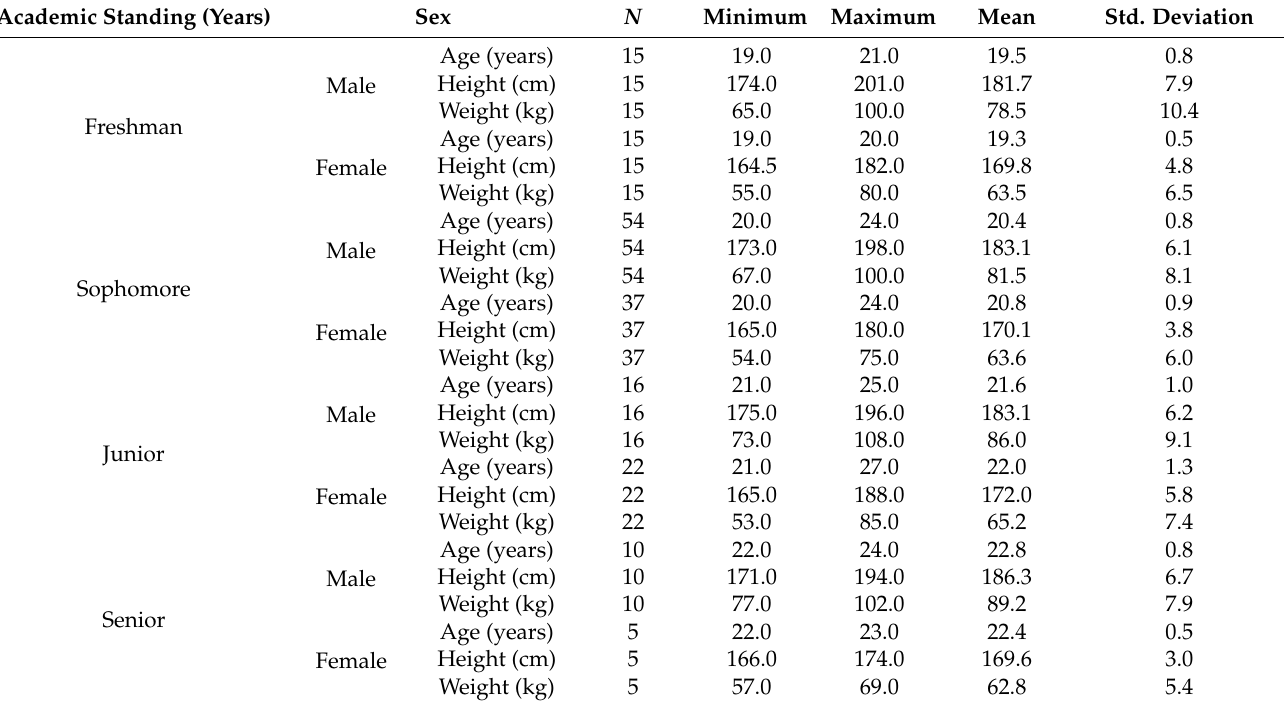
Table 1. Descriptive Statistics for Age, Height and Weight per Academic Years and